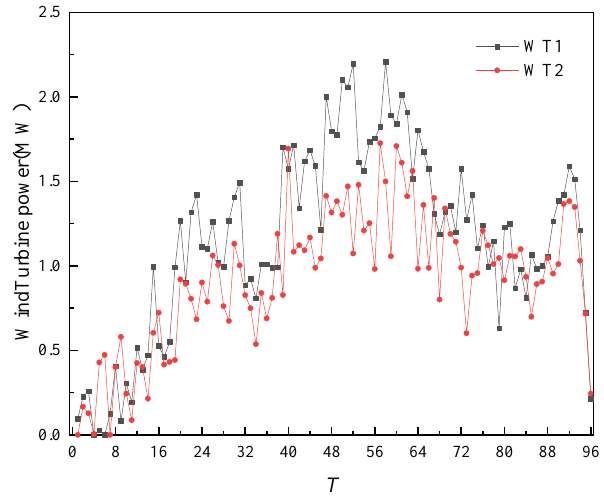
Figure 10. Intra-day forecast data of WT.